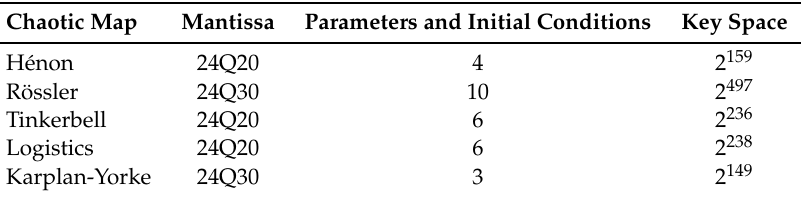
Table 1. Key space by using different chaotic